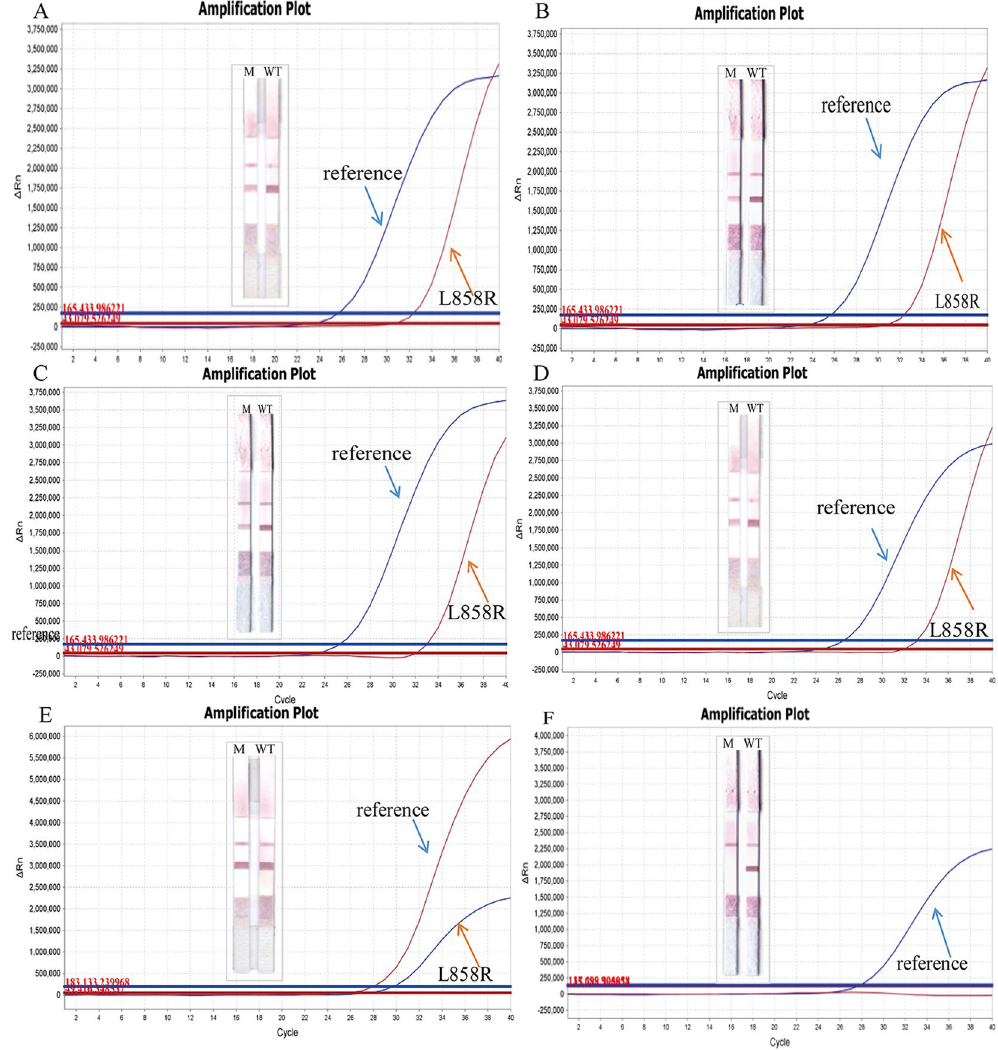
Figure 3. Results of L858R mutation detection by TaqMan-PCR method. Results were consistent with PCR- GoldMag LFA method. ( A , B , C , D ) representative samples were determined to be as L858R point mutation of EGFR by TaqMan-PCR. ( E ) Cell lines NCI-H-1975 were determined to be as L858R point mutation of EGFR by TaqMan-PCR. ( F ) The DNA control from whole blood collected from healthy individuals was determined to be wild-type EGFR by